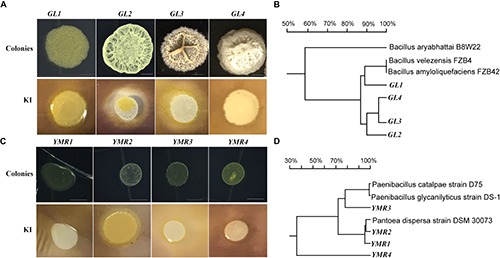
Isolation of endophytic bacteria from root tips. (A,C) Colonies and amylolytic capability of B.p.GL1-GL4, P.d.YMR1-YMR2, and P.g.YMR3-YMR4. The bacteria were cultured in LB medium containing 0.15% soluble starch for 24 h. Then drops of 1% KI solution were added and photographs were taken. (B,D) 16S DNA variable region sequence relationships of B.p.GL1-GL4, P.d.YMR1-YMR2, and P.g.YMR3-YMR4 determined using DNAMAN software.